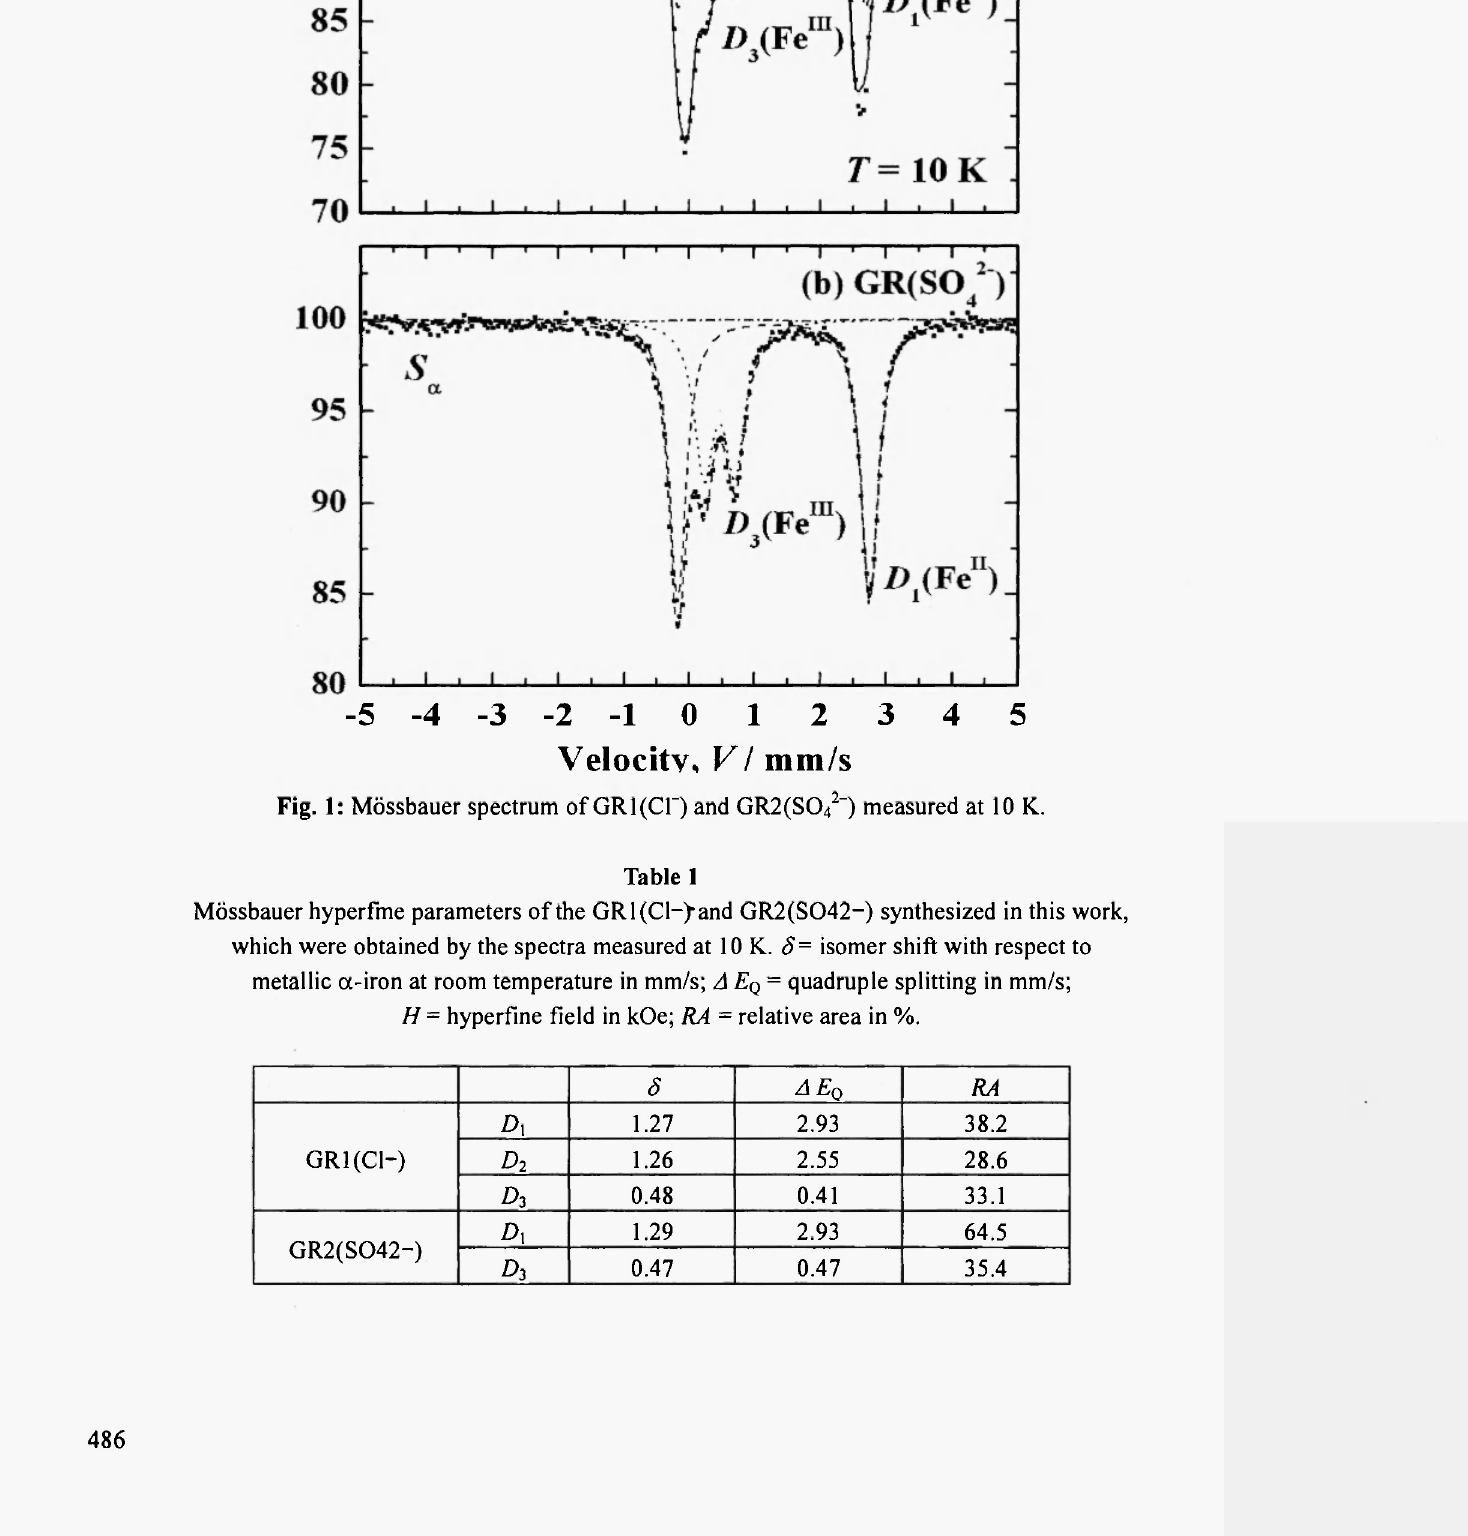
Fig. 1: Mössbauer spectrum of GR1(C1") and GR2(S0 4 2 ~) measured at 10 K.